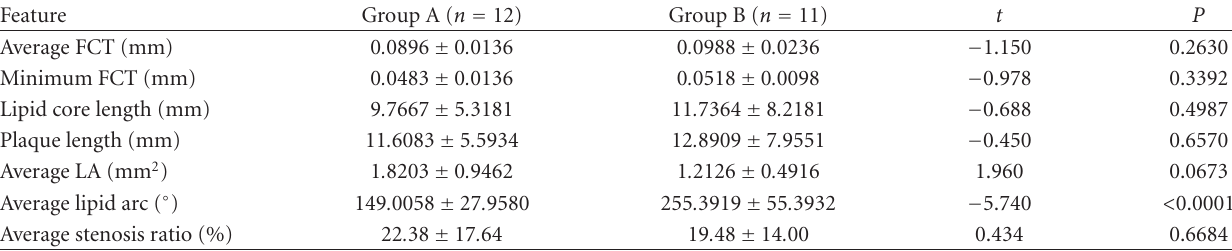
Table 1: Comparison of total plaque characteristics in the two experimental groups by OCT.